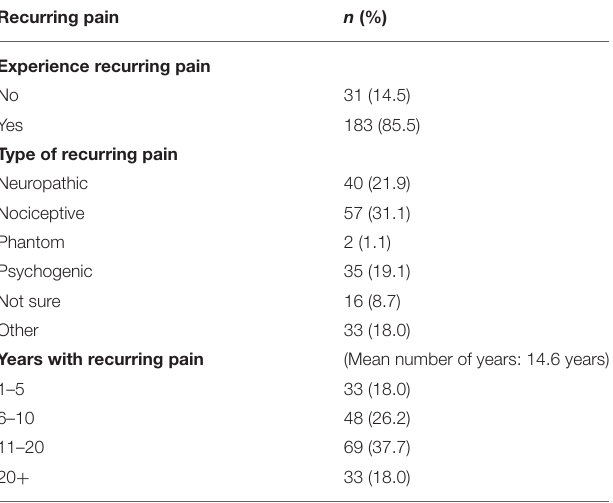
TABLE 1 | Demographic information of the medical cannabis patient cohort. Demographic information